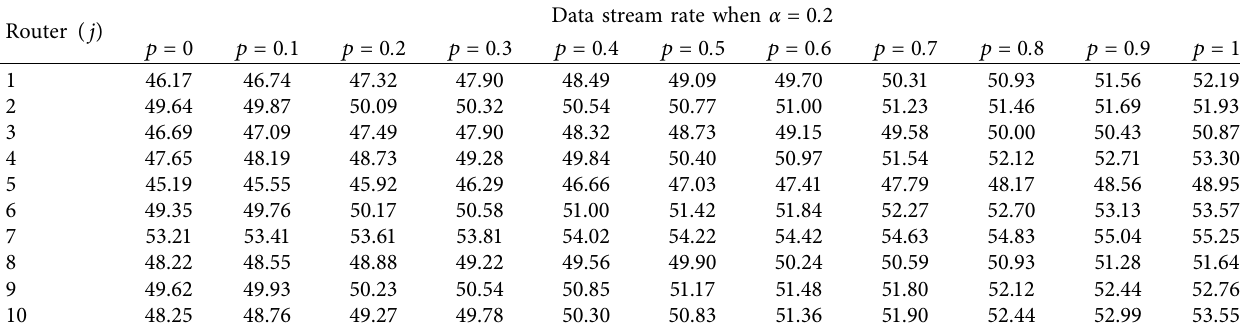
Table 5: Data stream rate for different values of p and α � 0 . 2.